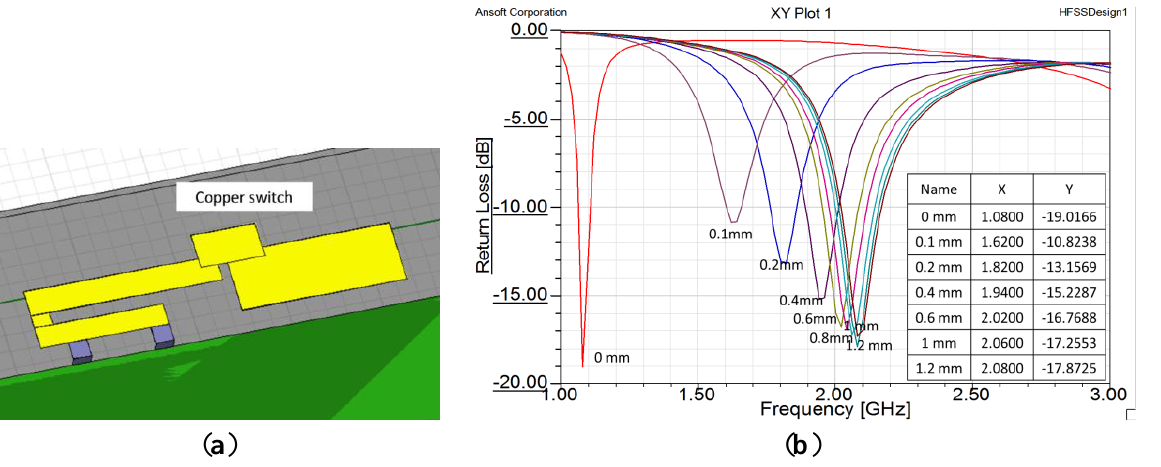
Figure 8. ( a ) Design model of copper sheet switch; ( b ) Result of height variation of switch. The horizontal axis represents frequency and the vertical axis represents return